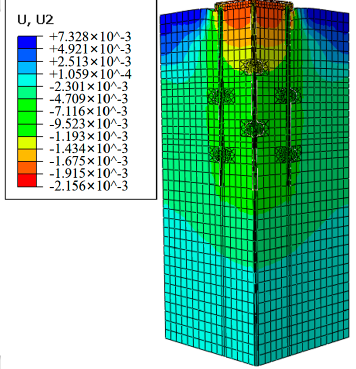
Figure 16. Displacement contour of 800 kPa load.